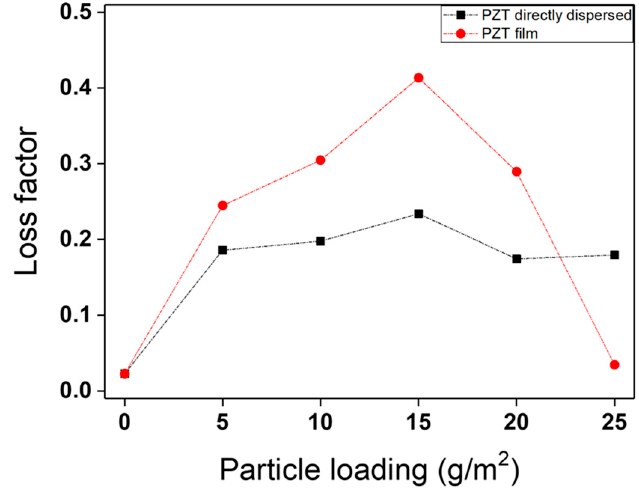
Figure 5. Loss factors of the specimens with PZT particle directly dispersed between the plies at 120 Hz. Comparison with the specimens with mixture films. Measurement data for different particle loadings.